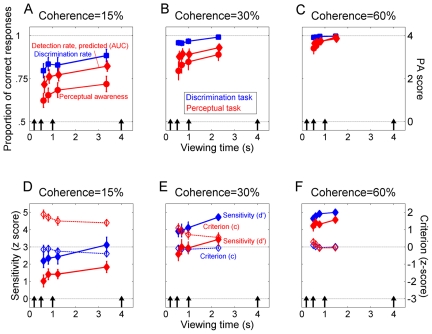
Time-course of discrimination capability and perceptual awareness.A–C: Effects of coherence and urgency on discrimination rate, perceptual awareness and AUC. Perfect discrimination (100%) corresponds to maximal AUC (A' = 1) and full visibility (PA = 4), while chance discrimination (50%) corresponds to zero-sensitivity (A' = 0.5) and null visibility (PA = 0). Note however that the PA scale is not linear with respect to the other two measures. The values are plotted on the horizontal axis in correspondence of the mean viewing time, and represent means ± S.E.M. across subjects. Black arrows: offset of the fixation dot in each urgency condition. Time zero represents stimulus onset. D–F: Effects of coherence and urgency on sensitivity and response criterion. Same convention as in A–C.